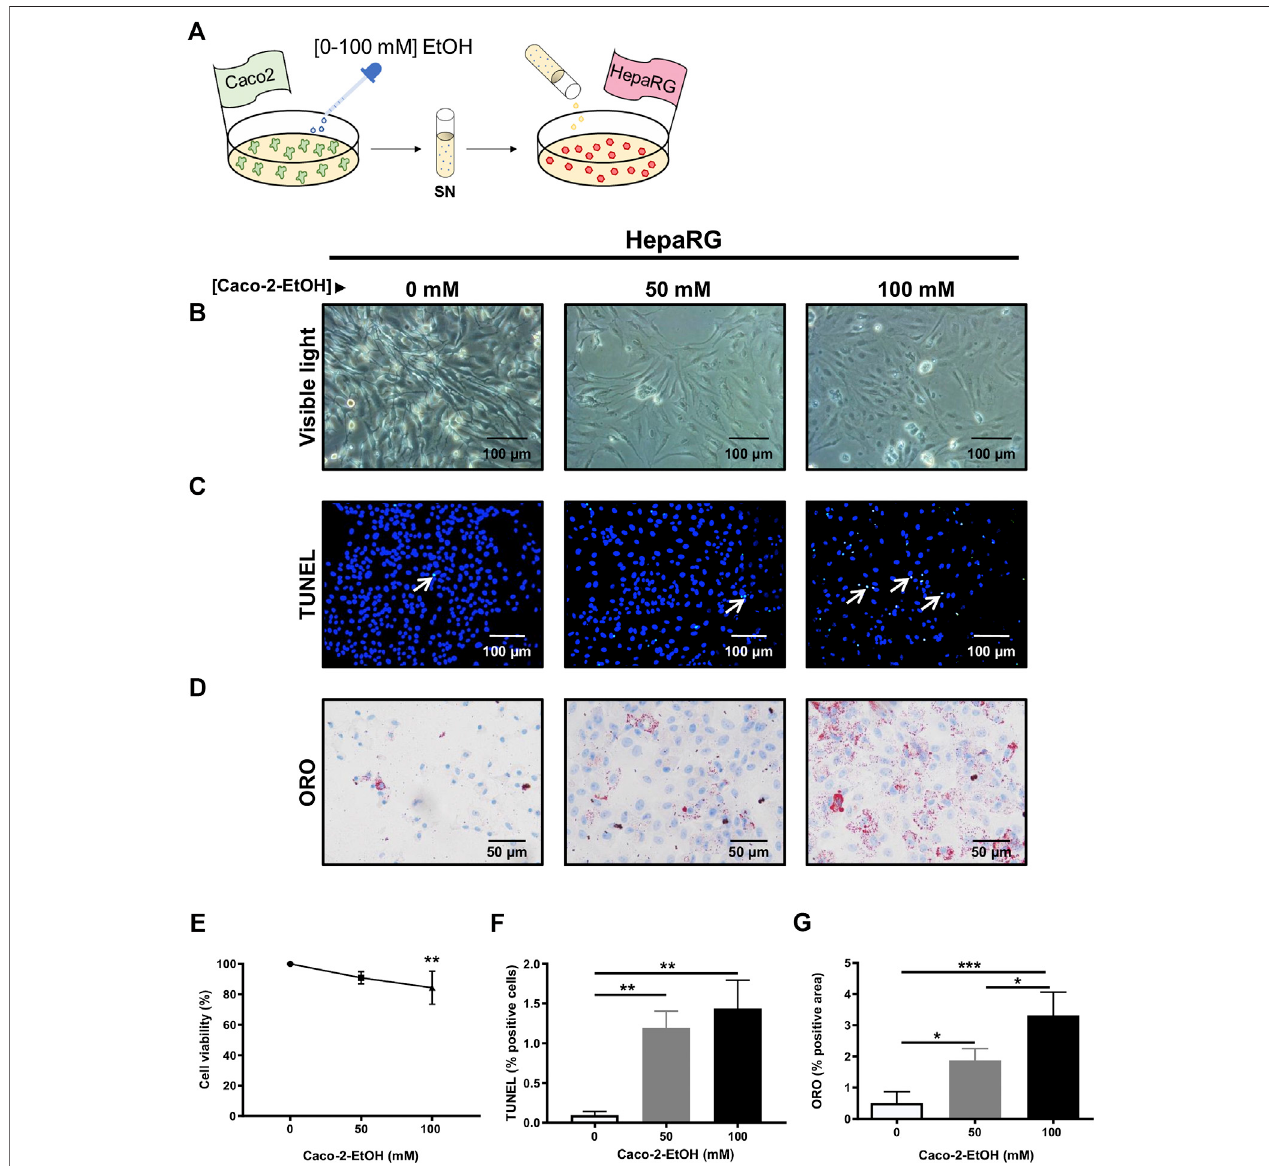
FIGURE 4 | HepaRG cells challenged with supernatant from EtOH-treated Caco-2 cells displayed exacerbated cell damage. (A) Experimental in vitro model of the effect of acute alcohol injury on intestinal epithelial permeability and on liver injury: cultures of HepaRG cells were exposed to the supernatant from Caco-2 cells that had been previouslytreatedwithdifferentconcentrationsofEtOH [0 – 100 mM]. (B) HepaRGcellsexposed tothesupernatantofCaco-2cellstreatedwithEtOH [0 – 100 mM] showed by visible light ( n (cid:1) 4/group). (C) TUNEL staining was performed in HepaRG cells exposed to the supernatant of Caco-2 cells treated with EtOH [0 – 100 mM]. (D) OilRedO(ORO)stainingwasperformedinHepaRGcellsexposedtothesupernatantofCaco-2cellstreatedwithEtOH[0 – 100 mM]. (E) Cellviabilityof HepaRG cells challenged with supernatant from EtOH-treated Caco-2 cells determined by CCK8 ( n (cid:1) 6/group). (F) Quanti fi cation of TUNEL positive cells HepaRG cells exposedtosupernatant from EtOH-treatedCaco-2cells( n (cid:1) 3/group). (G) Quanti fi cationoflipiddroplets byOROpositiveareainHepaRG cellsexposed tosupernatant from EtOH-treated Caco-2 cells (%) ( n (cid:1) 3 – 4/group; * p < 0.05, *** p < 0.001).